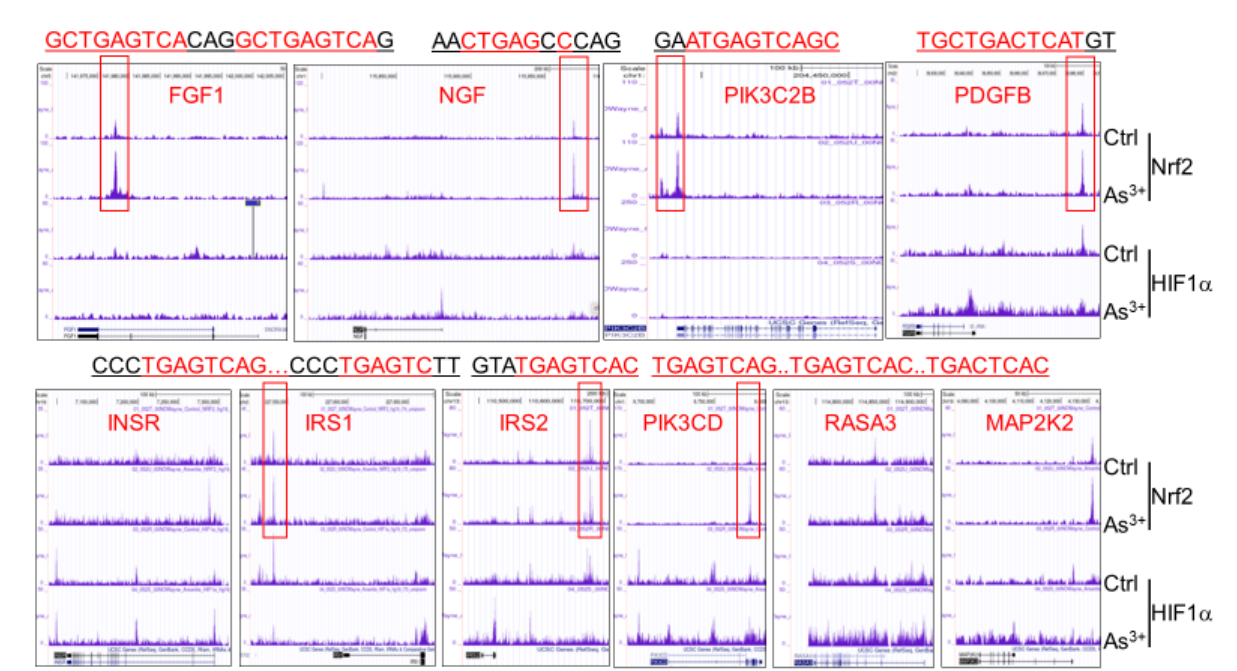
Figure 1. Arsenic-induced expression of growth factors is Nrf2 dependent. Panels show screenshot of Genome Browser for these indicated growth factor genes from ChIP-seq. The major Nrf2 peaks detected on these genes are highlighted with red boxes. The sequences for the conserved Nrf2-binding elements in these indicated Nrf2 peaks are shown on the top of each panel. Data are derived from global ChIP-seq using antibodies against Nrf2 and HIF1α, respectively, and the control cells and cells treated with 1 μM arsenic (As 3+ ) for 6 h.